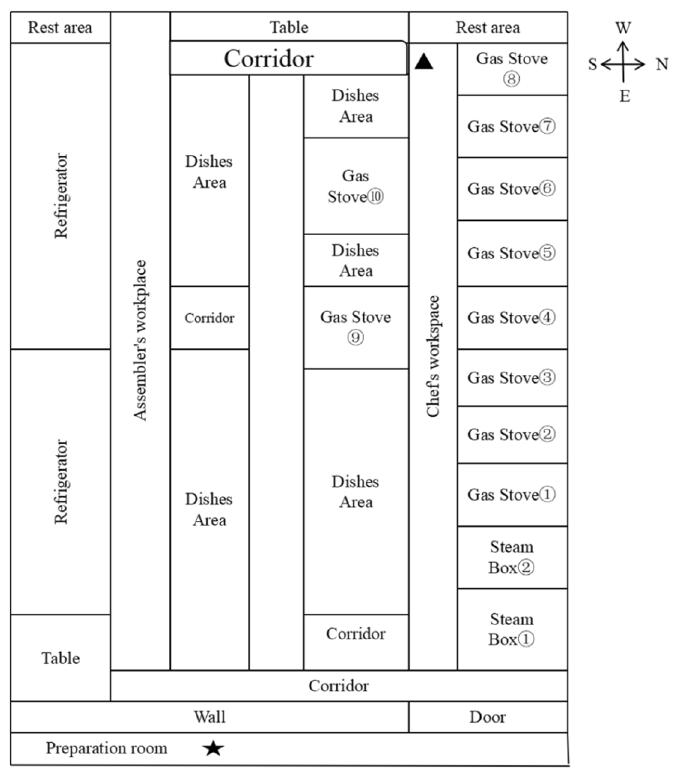
Figure 1. Workshop layout and sampling locations marked with a triangle and an asterisk. Sampling filled star: background; filled triangle: operation